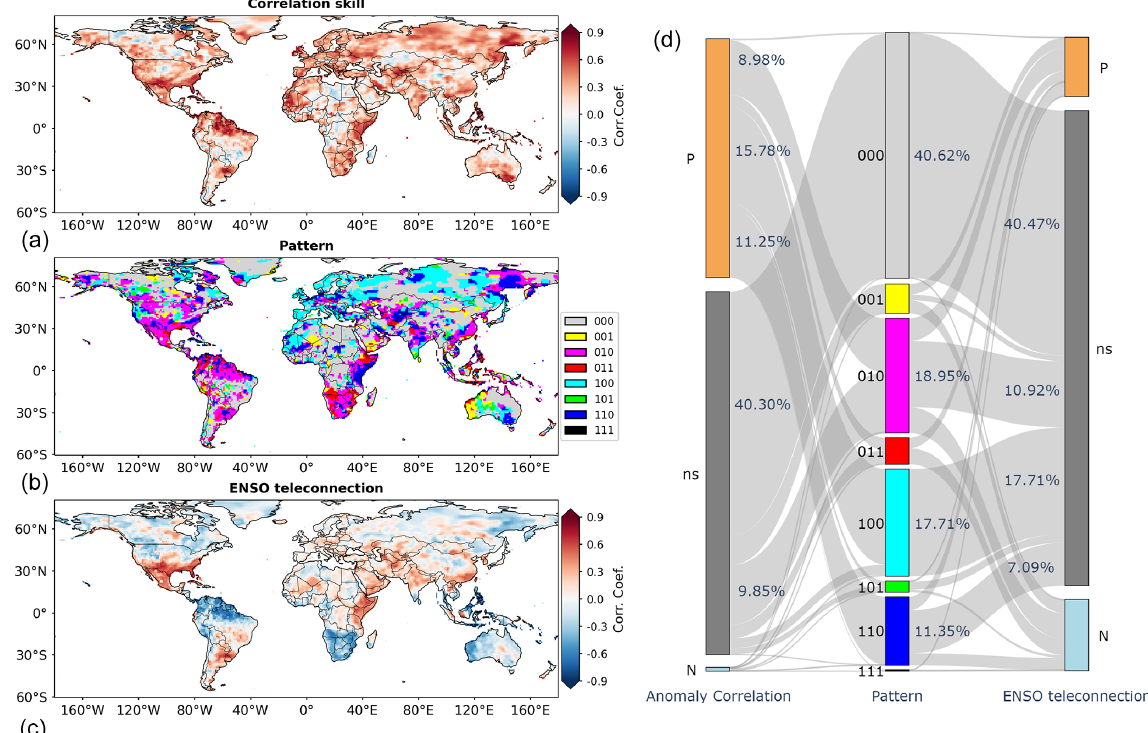
Figure 12. Spatial plots of correlation skill (a) and ENSO teleconnection (c) under the eight patterns (b) at the global scale and the Sankey diagram showing the percentages of grid cells exhibiting P, ns and N correlation skill/ENSO teleconnection (d)